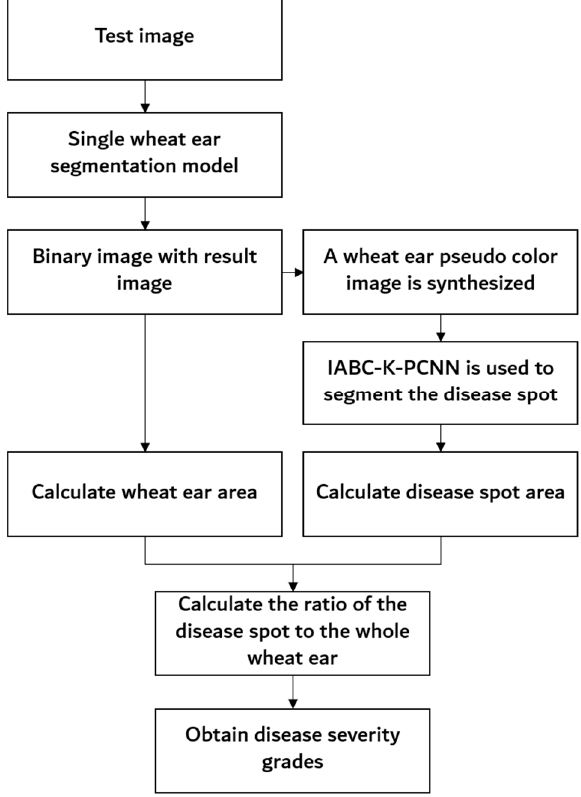
Figure 3. The workflow of the study.